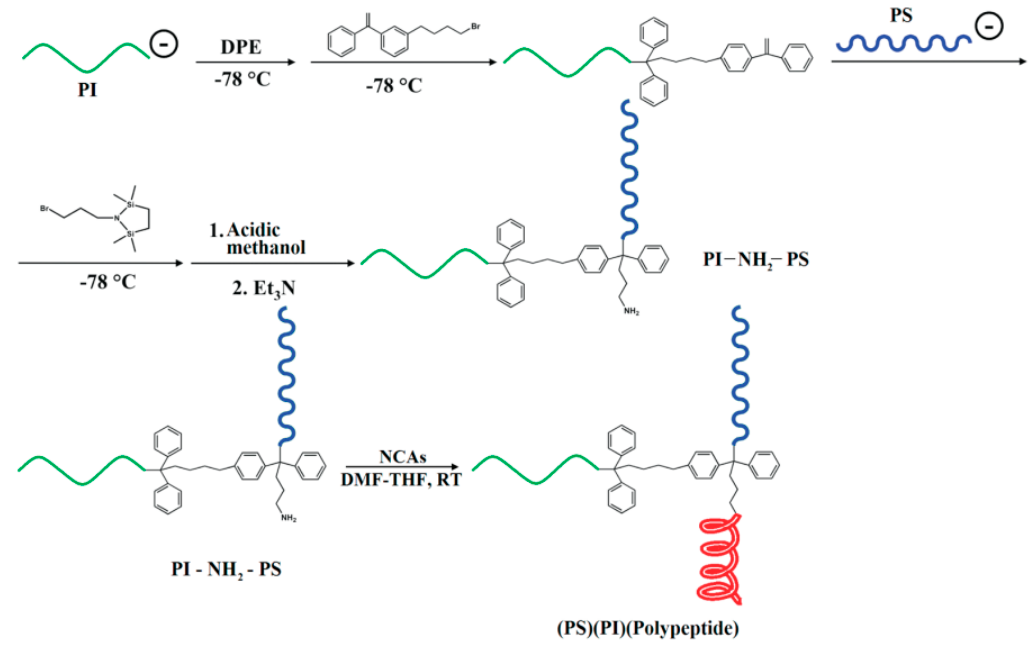
Figure 46. Synthesis of the 3-Miktoarm Star Chimeras (PS)(PI)(Polypeptide). Reproduced with permission from reference [177].